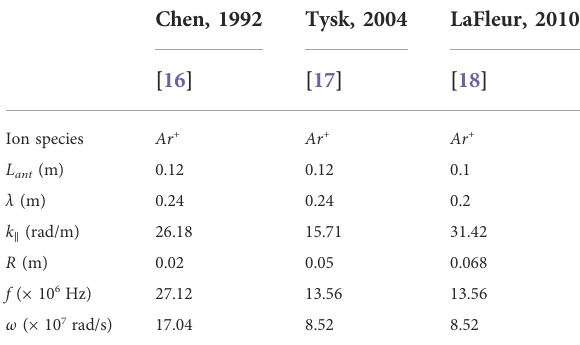
TABLE 1 Experimental parameters obtained for the data sets of Figure 2, used for the validation of the simpli fi ed helicon wave dispersion model of Eq. 3.